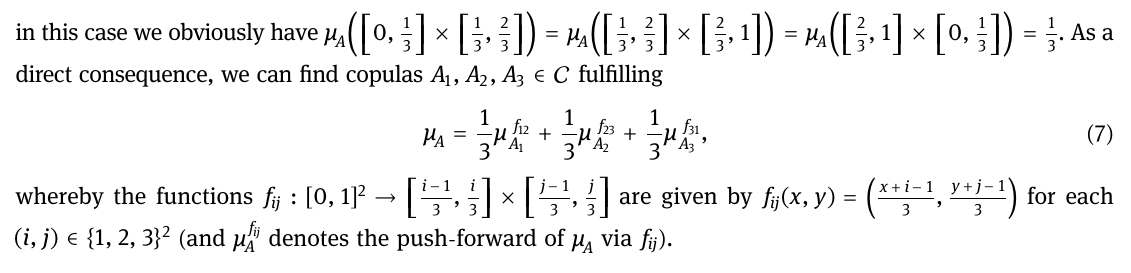
for s 0.3 = ( left panel ) and s 0.8 = ( right panel ) considered C s